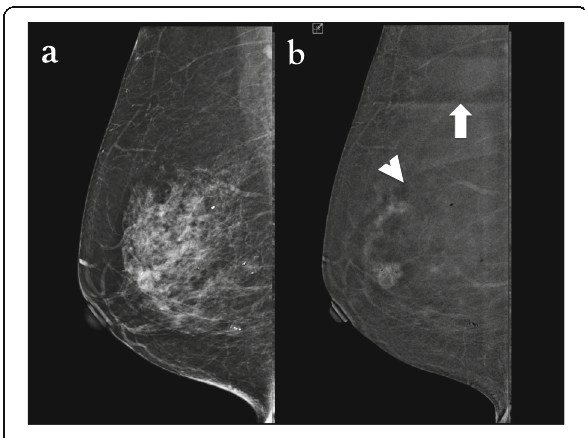
Fig. 15 Ghosting artefact: a 50-year-old woman presented with a right breast lump. a The LE CEDM image shows no obvious artefacts, and ( b ) ghosting of the latent CC view (arrowhead) of the previously imaged breast is projected within the MLO image and an axillary line artefact (arrow) is also evident in this